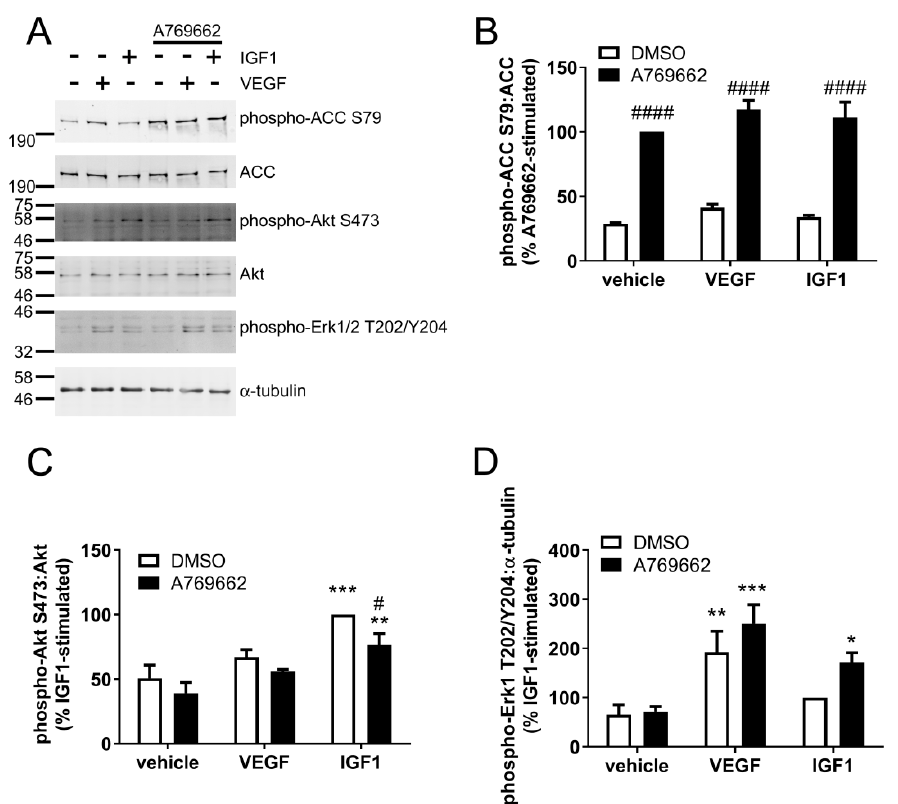
Figure 7. A769662 tends to attenuate IGF1-stimulated Ser473 Akt phosphorylation but has no effect on VEGF signalling in HUVECs. HUVECs were stimulated with A769662 (50 µM 45 min) prior to VEGF (10 ng/mL, 10 min) or IGF1 (25 ng/mL, 10 min). Cell lysates were prepared, proteins resolved by SDS-PAGE and immunoblotted with the antibodies indicated. ( A ) Representative immunoblots from four independent biological replicates with molecular weight markers indicated. Total ACC protein level was assessed by stripping and re-probing the membranes. ( B – D ) Densitometric quantification of ( B ) ACC Ser79, ( C ) Akt Ser473 or ( D ) Erk1 Thr202/Tyr204 phosphorylation normalised to total ACC, Akt or α -tubulin levels respectively (mean ± SEM). * p < 0.05, ** p < 0.01, *** p < 0.001 relative to absence of IGF1/VEGF. # p < 0.05, #### p < 0.0001 relative to absence of A769662.